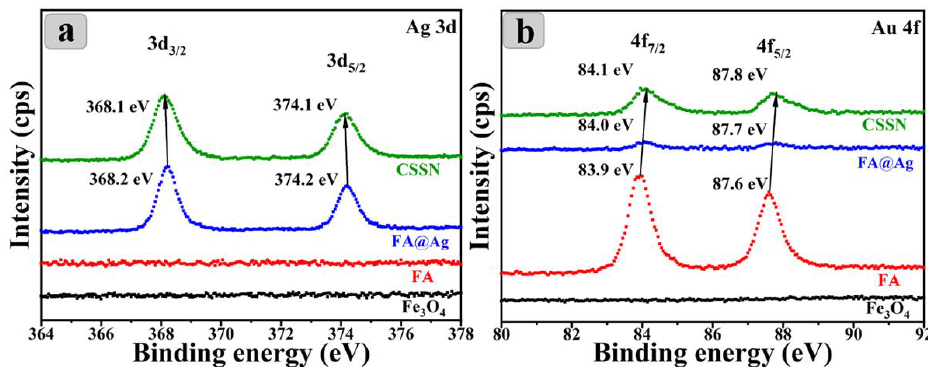
Figure 3. High-resolution XPS spectra of Fe 3 O 4 hollow spheres, FA, FA@Ag, and CSSN NCs: Ag 3d ( a ) and Au 4f ( b ).